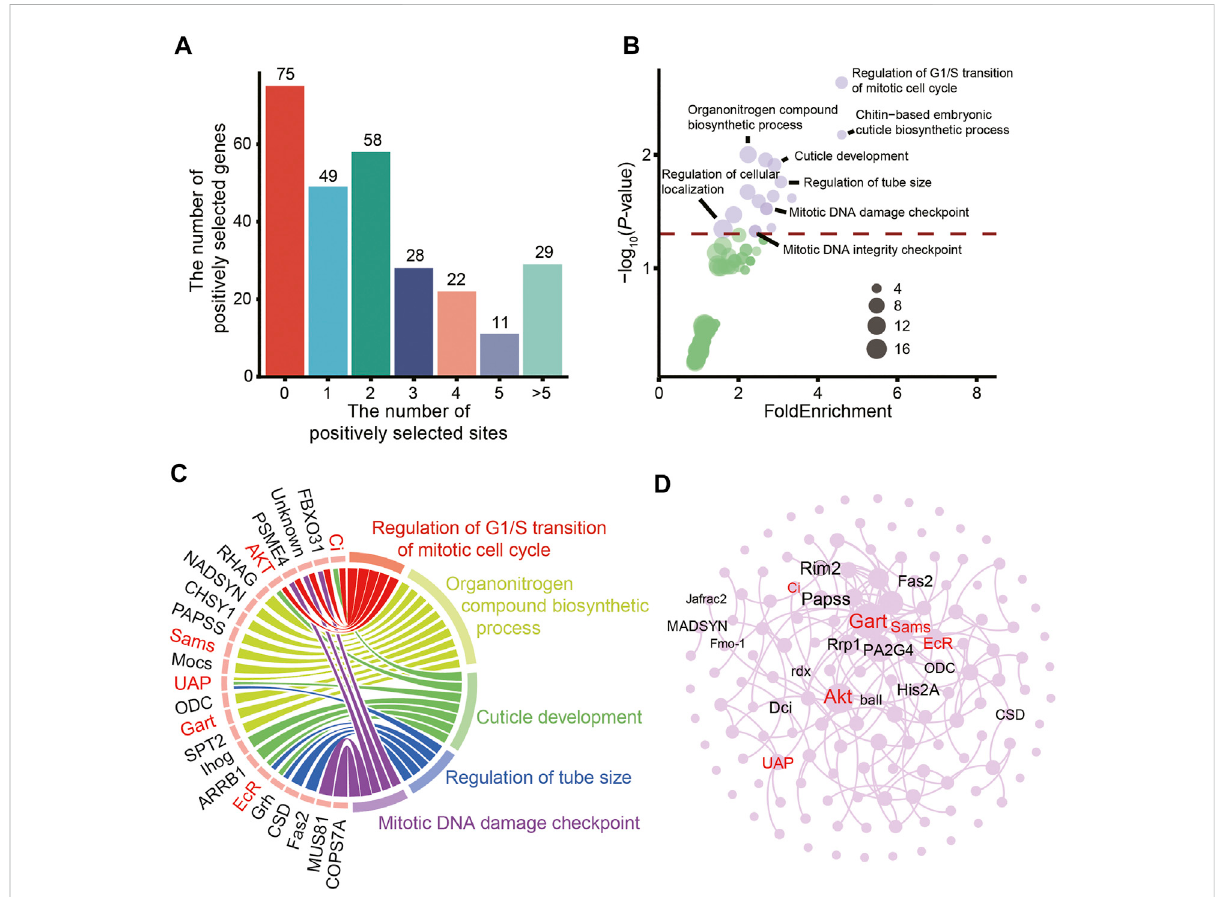
FIGURE 4 Positively selected genes expressed in the eggs of A. gigantea . (A) . The distribution of PSGs by positively selected site number; (B) . Bubble plot fortheenrichedKEGGterms; (C) .ChorddiagramofGOtermsandrelatedgenes; (D) .Anetworkofpositivelyselectedgenesinthe A.gigantea ’